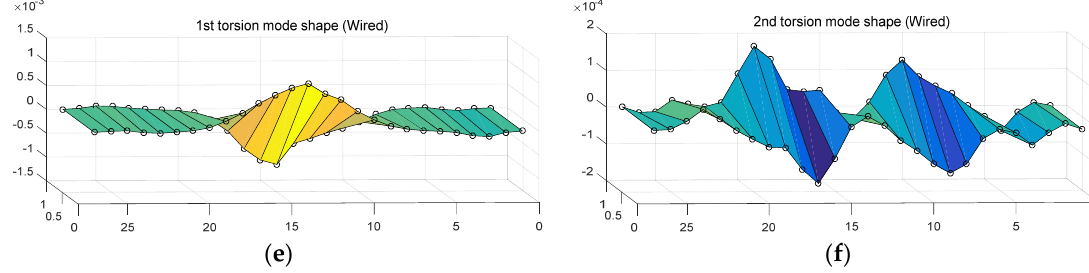
Figure 11. Wired mode shape: ( a ) 1st bending mode; ( b ) 2nd bending mode; ( c ) 3rd bending mode; ( d ) 4th bending mode; ( e ) 1st torsion mode; ( f ) 2nd torsion mode.